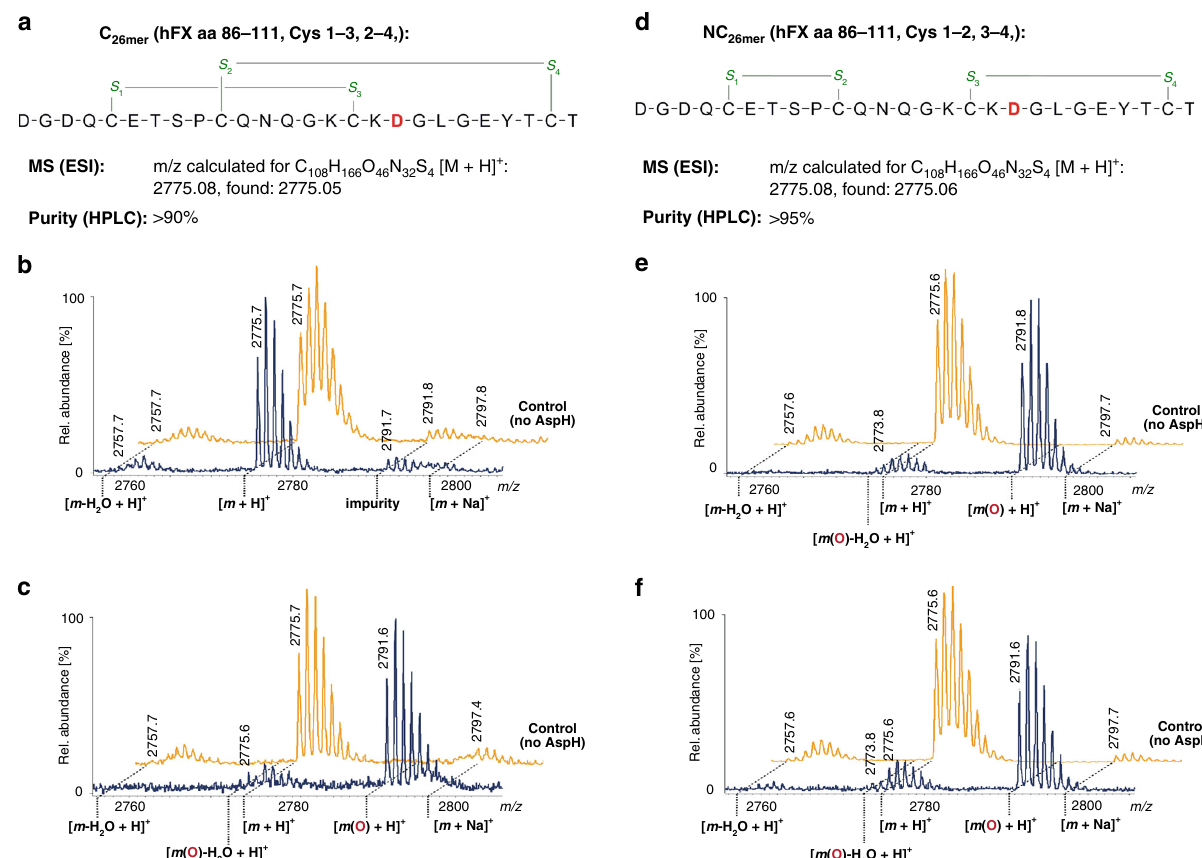
Fig. 7 The EGFD disul fi de connectivity determines the degree of AspH-catalysed hydroxylation under non-redox conditions. End-point turnover reactions were performed as in the Methods Section. Light orange graphs represent controls in which AspH was replaced by buffer. a Schematic structure and calculated mass of the C 26mer peptide, bearing a canonical disul fi de arrangement (Cys1 – 3, 2 – 4); disul fi des are shown in green, the hydroxylation site (Asp103 hFX ) is indicated in red. b No hydroxylation of the C 26mer peptide was observed under standard (non-redox) conditions; ~7% impurity (might correspond to an oxidized byproduct) was observed in this sample, including the control samples. c >95% Hydroxylation of the C 26mer peptide was observed under redox conditions. d Schematic structure and calculated mass of the NC 26mer peptide, bearing a non-canonical disul fi de arrangement (Cys1 – 2, 3 – 4); disul fi des are in green, the hydroxylation site (Asp103 hFX ) is in red. e >95% Hydroxylation of the NC 26mer peptide was observed under standard (non-redox) conditions. f ~83% Hydroxylation of the NC 26mer peptide was observed under redox